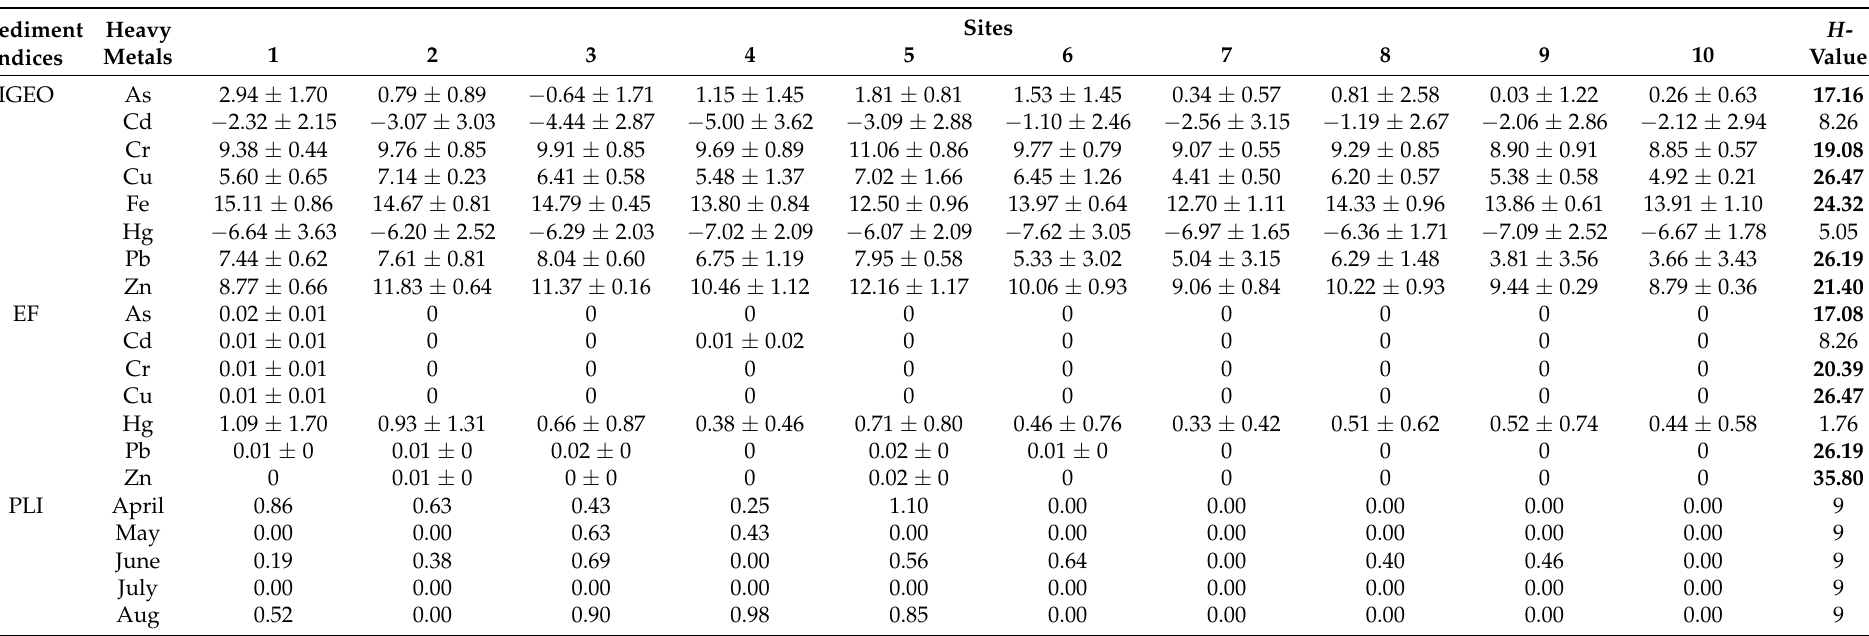
Table 1. The geo-accumulation index (Igeo), enrichment factor (EF), and pollution load index (PLI) indices mean and ± standard deviation for measured heavy metals at 10 sites along the Swartkops River system over a period of six months (April 2018–September 2018). Bolded H -values indicate significant differences (Kruskal–Wallis ANOVA, p < 0.05).